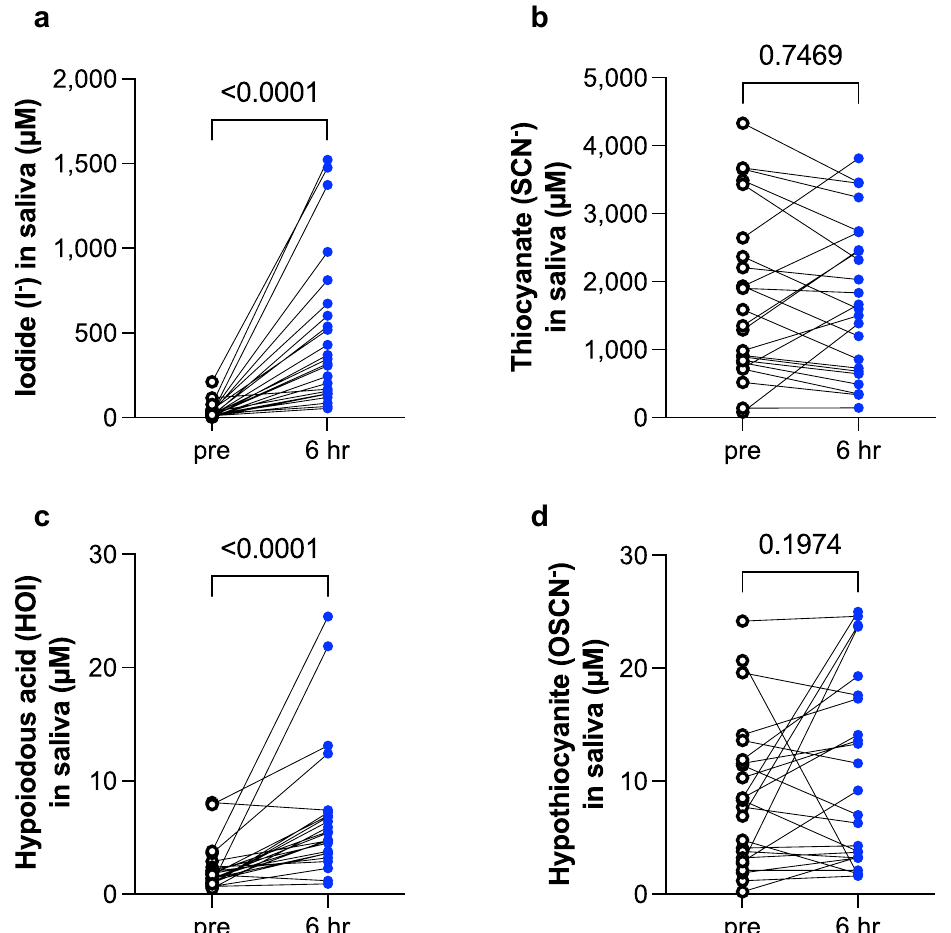
Figure 1. Study 1: Salivary contents of iodide, thiocyanate (SCN − ), hypoiodous acid (HOI) and hypothiocyanite (OSCN − ) before and 6 h after an iodinated contrast load. Saliva was collected before (pre) and 6 h after an iodinated contrast load. Salivary levels of iodide ( a ), SCN − ( b ), HOI ( c ), and OSCN − ( d ) were measured as indicated in Methods. All data were analyzed by paired Wilcoxon matched-pairs signed rank test, two-tailed (n = 24 pairs). P values shown above